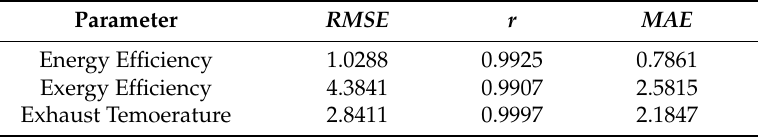
Table 4. The results of ANN